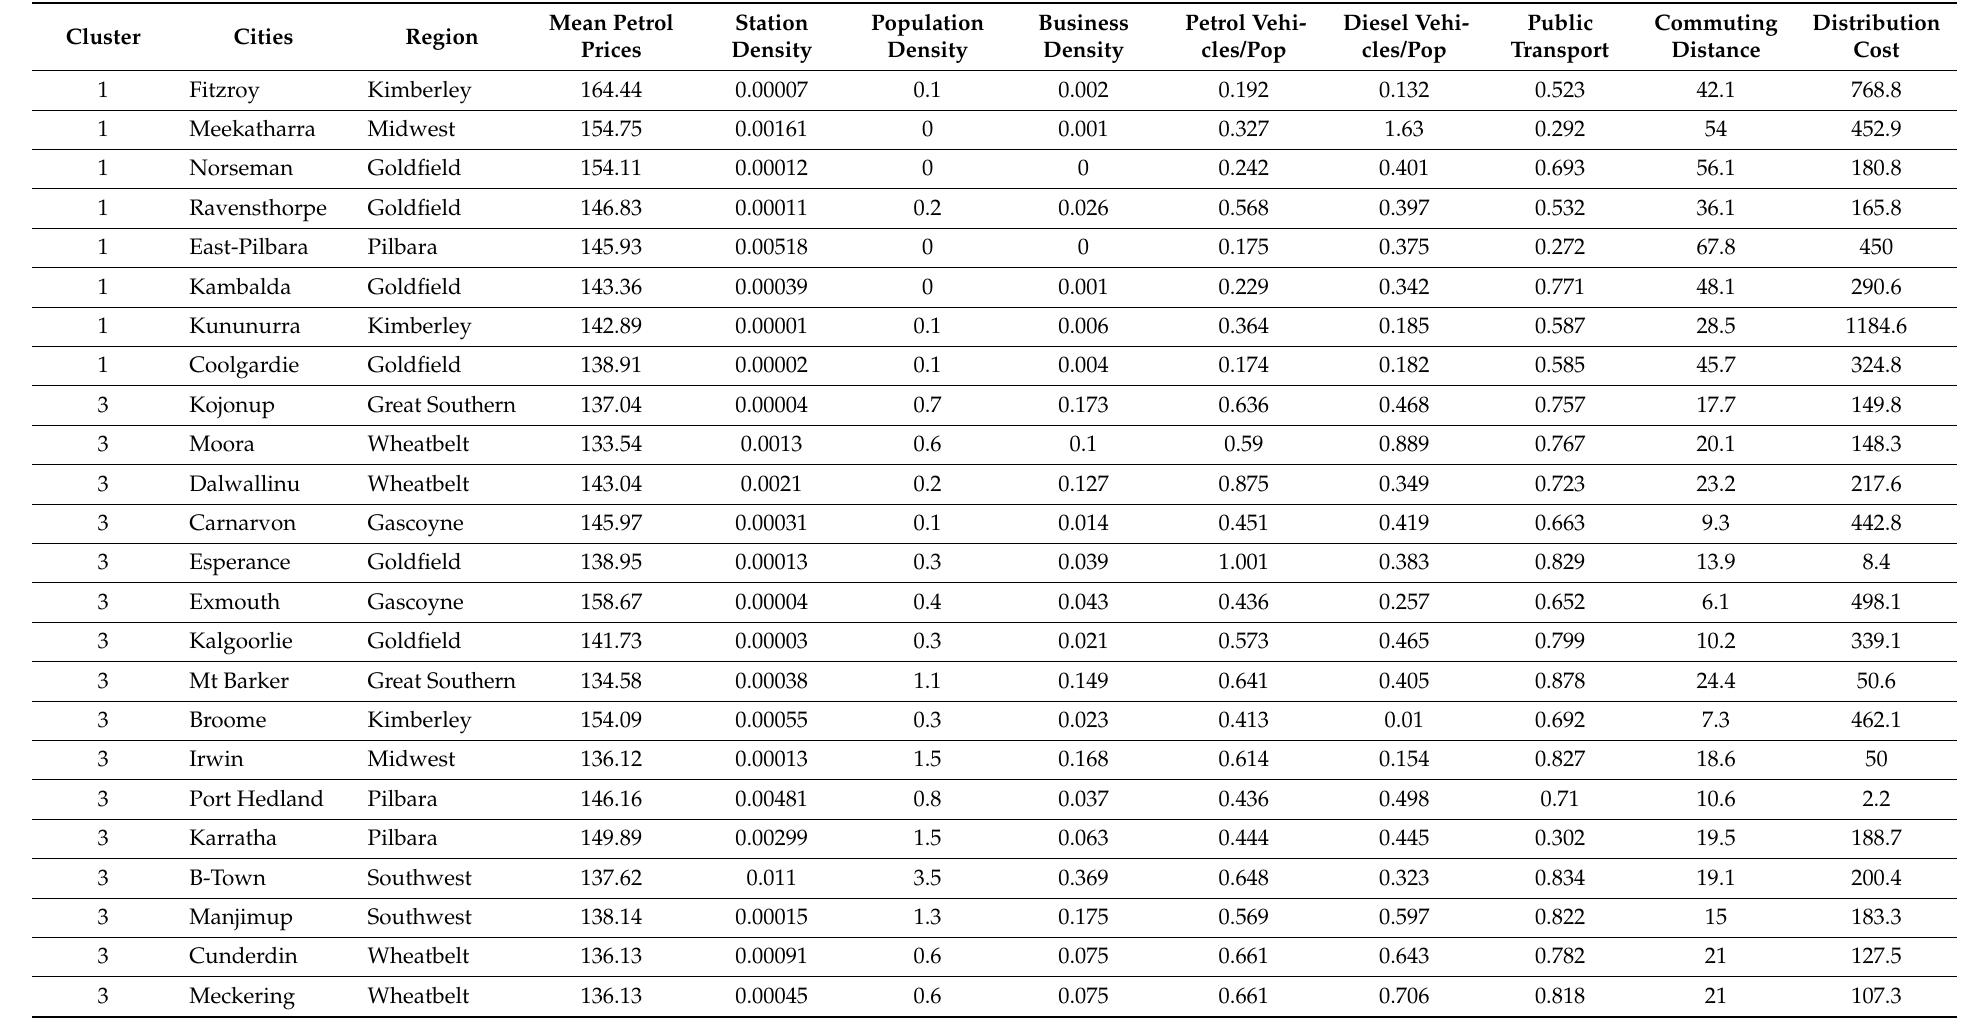
Table 5. Results for cities ranked based on